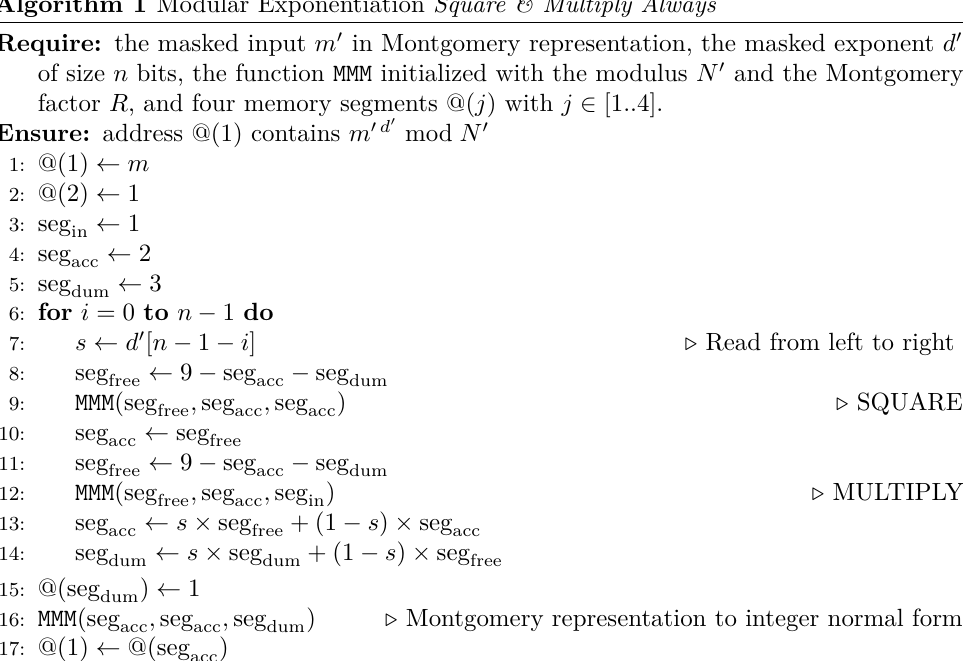
Algorithm 1 Modular Exponentiation Square & Multiply